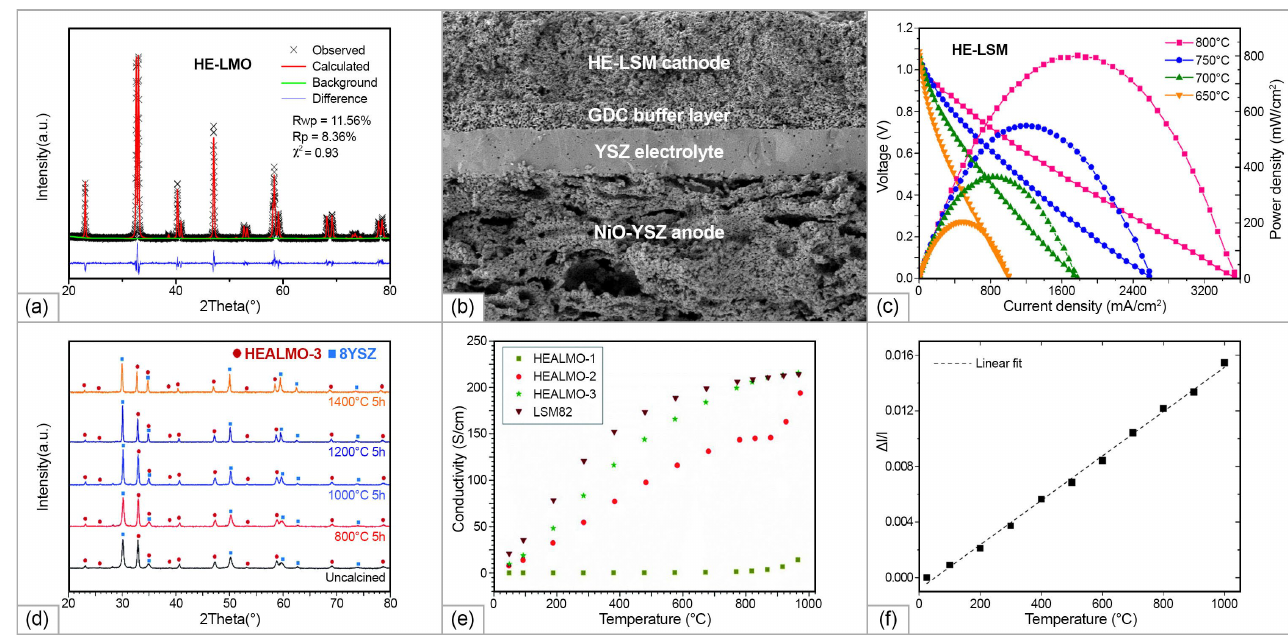
Figure 15. ( a ) XRD Rietveld refinement of LaMn 0.2 Fe 0.2 Co 0.2 Ni 0.2 Cu 0.2 O 3- δ ; ( b ) cross-section image of NiO-YSZ|YSZ|GDC|HE_LSM single cell; ( c ) typical I–V–P plots for NiO-YSZ|YSZ|GDC|HE_LSM single cell; ( d ) XRD patterns of La 0.2 Nd 0.2 Sm 0.2 Ca 0.2 Sr 0.2 MnO 3 (HEALMO-3)+YSZ mixtures heated at